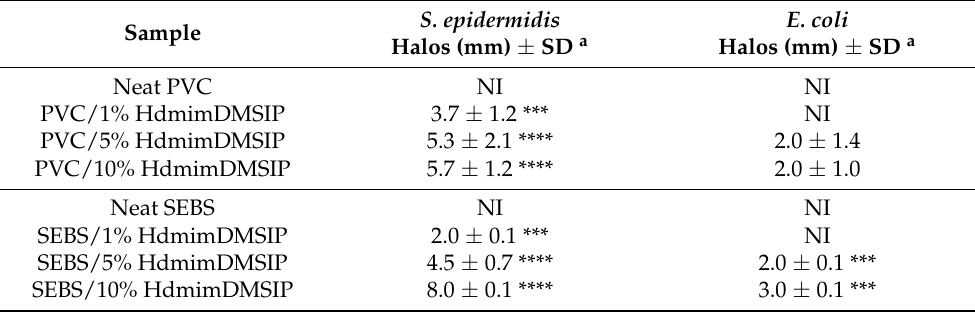
Table 2. Inhibition zones induced by PVC and SEBS films loaded with different percentages